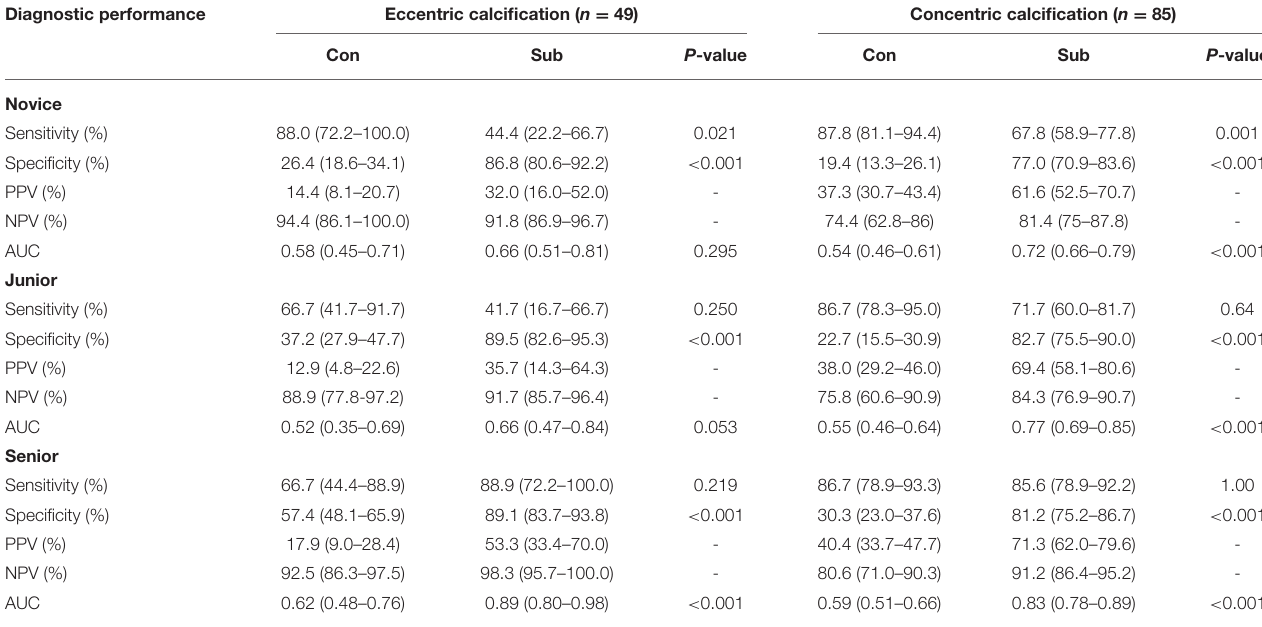
TABLE 5 | Subgroup analysis of diagnostic accuracy of eccentric calcification and concentric calcification by readers with different